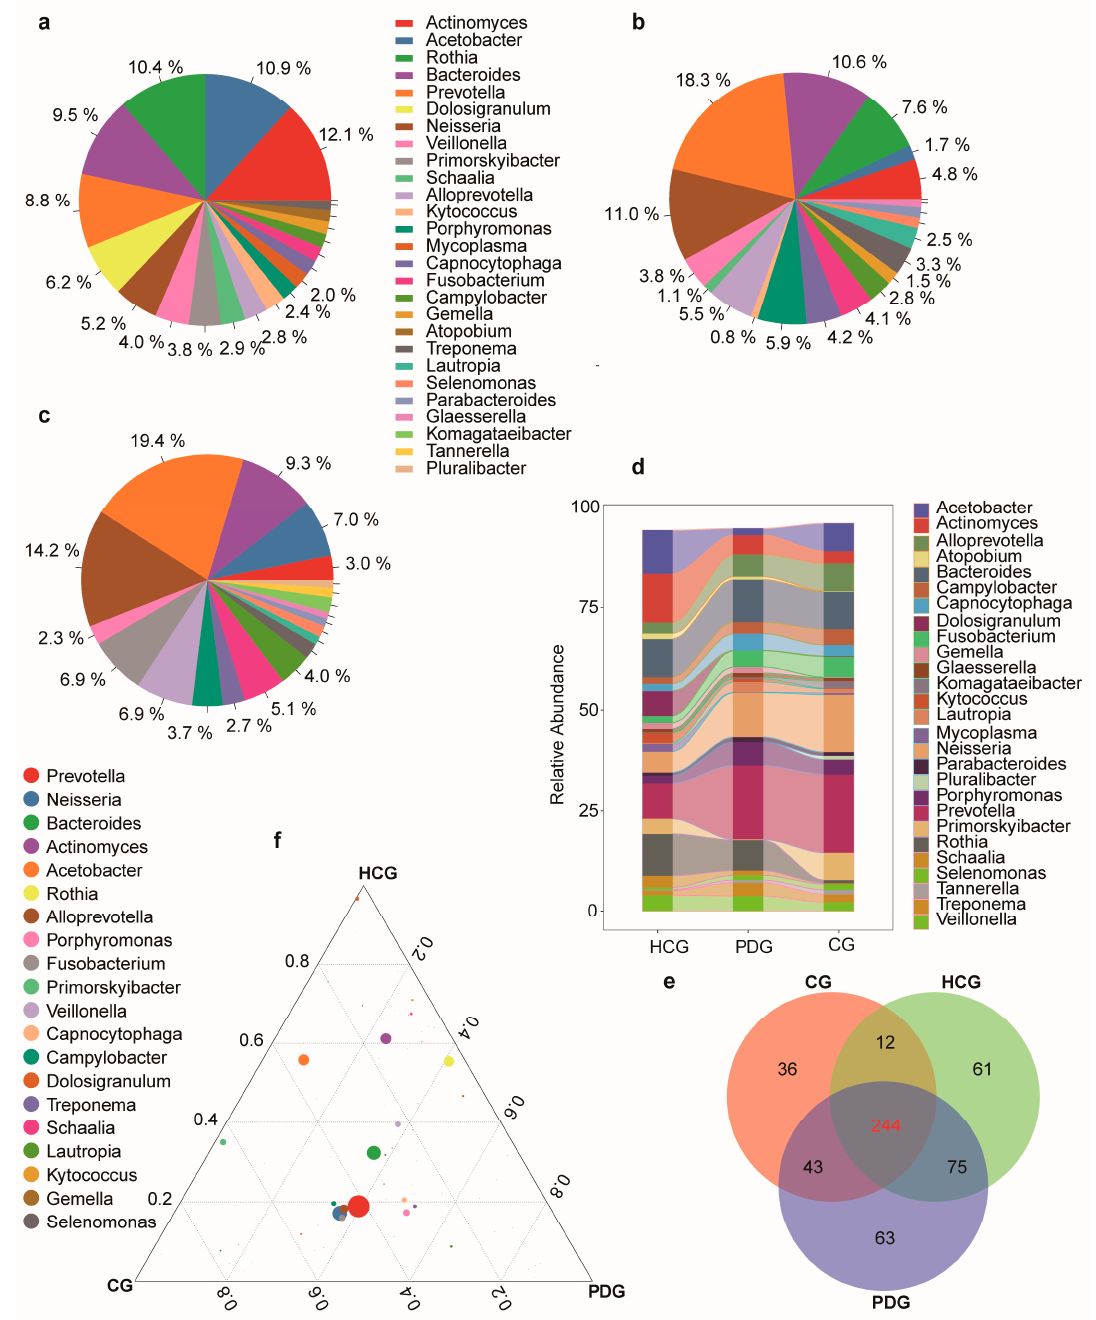
Figure 1. Oropharyngeal bacterial alterations among HCG, PDG, and CG. Average compositions of relative abundance of the top 20 bacterial genera for ( a ) HCG, ( b ) PDG, and ( c ) CG. ( d ) Alterations in the top 20 bacterial genera among the three groups. ( e ) The shared and unique genera of the three groups. ( f ) Ternary plots depicting the 244 shared genera of the three groups. The sum of the proportion for one specific bacterium in the three groups was set to 1, and the proportion of one specific bacterium in each group is equal to its corresponding relative abundance divided by the relative abundance sum of these bacteria in the three groups. The sizes of the circles represent the relative abundance of the genus. HCG: healthy control group. PDG: period of disease group. CG: convalescent